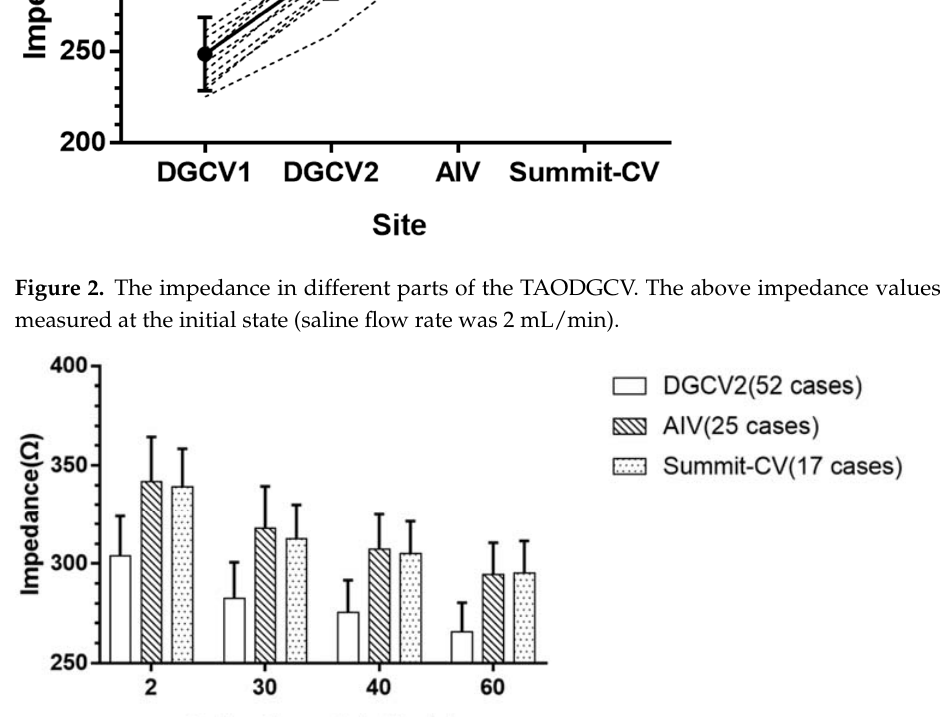
Figure 3. The average impedance under the different saline flow rates. DGCV2 = distal great cardiac vein 2; AIV = anterior interventricular vein; Summit-CV = summit communicating vein at the top of the left ventricle.